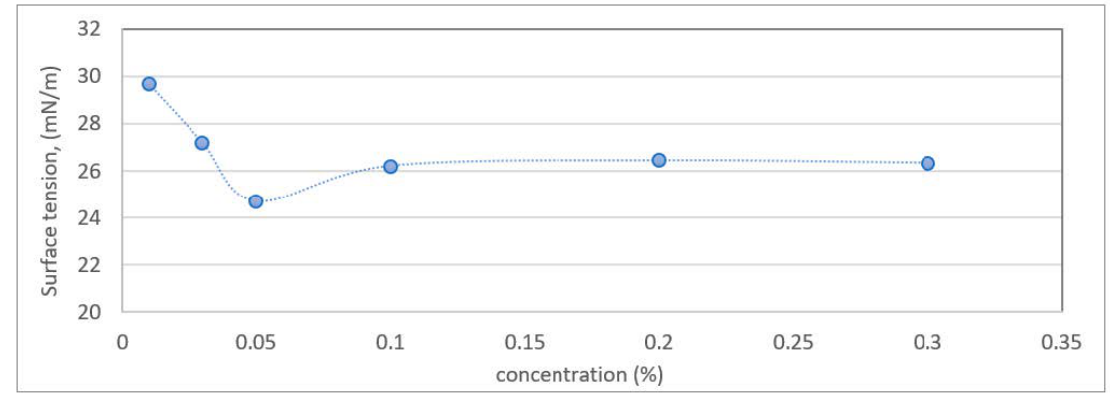
ff erent concentrations.